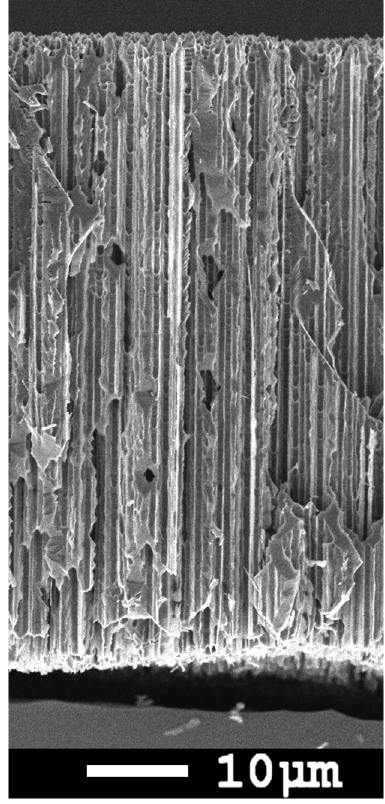
Figure 1. SEM image of the cross section of a macroporous membrane [10].